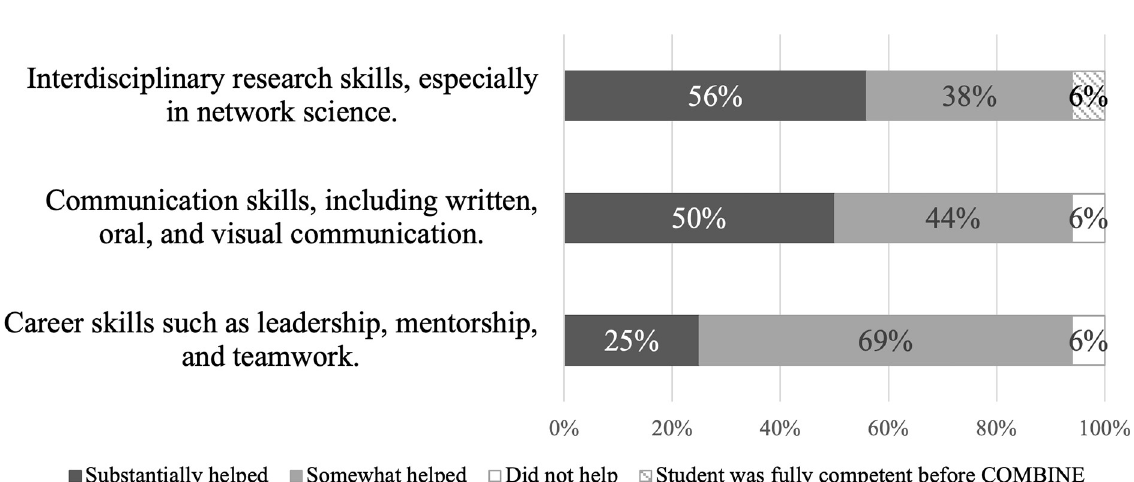
Fig 6. Faculty advisor ratings of how helpful the COMBINE program was to their student in the three program objective areas. Note . Percentages were calculated out of the total number of survey responses (n = 16). Percentages may sum to greater than 100% due to rounding.